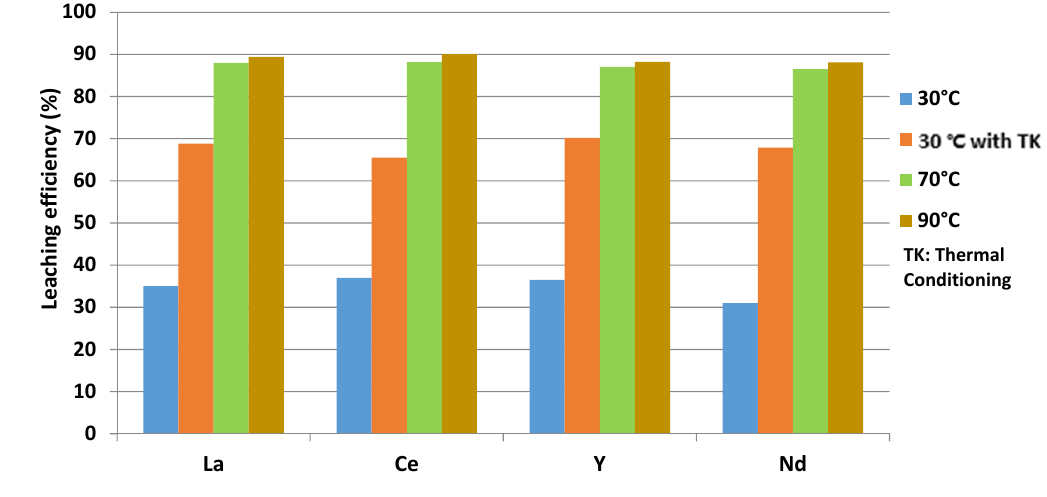
Figure 5. Leaching efficiency of La, Ce, Y and Nd.